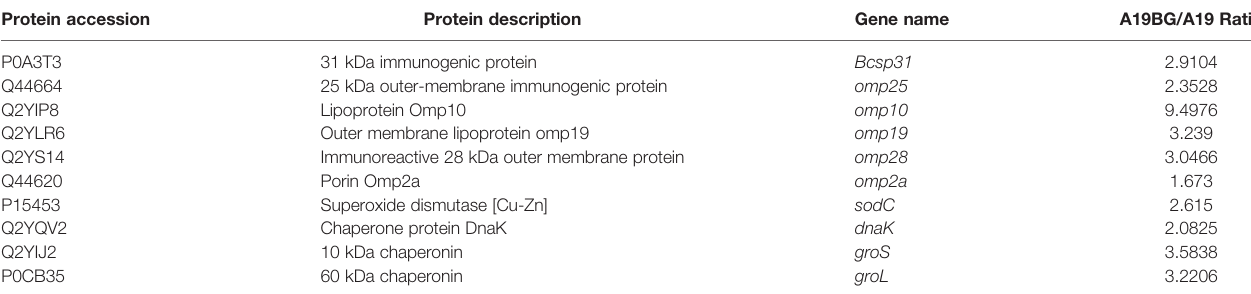
TABLE 1 | Immunogenic proteins co-occurring in A19 and A19BG. Protein